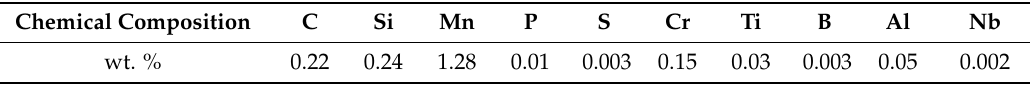
Table 1. Chemical composition of 22MnB5 steel blanks (wt. %).